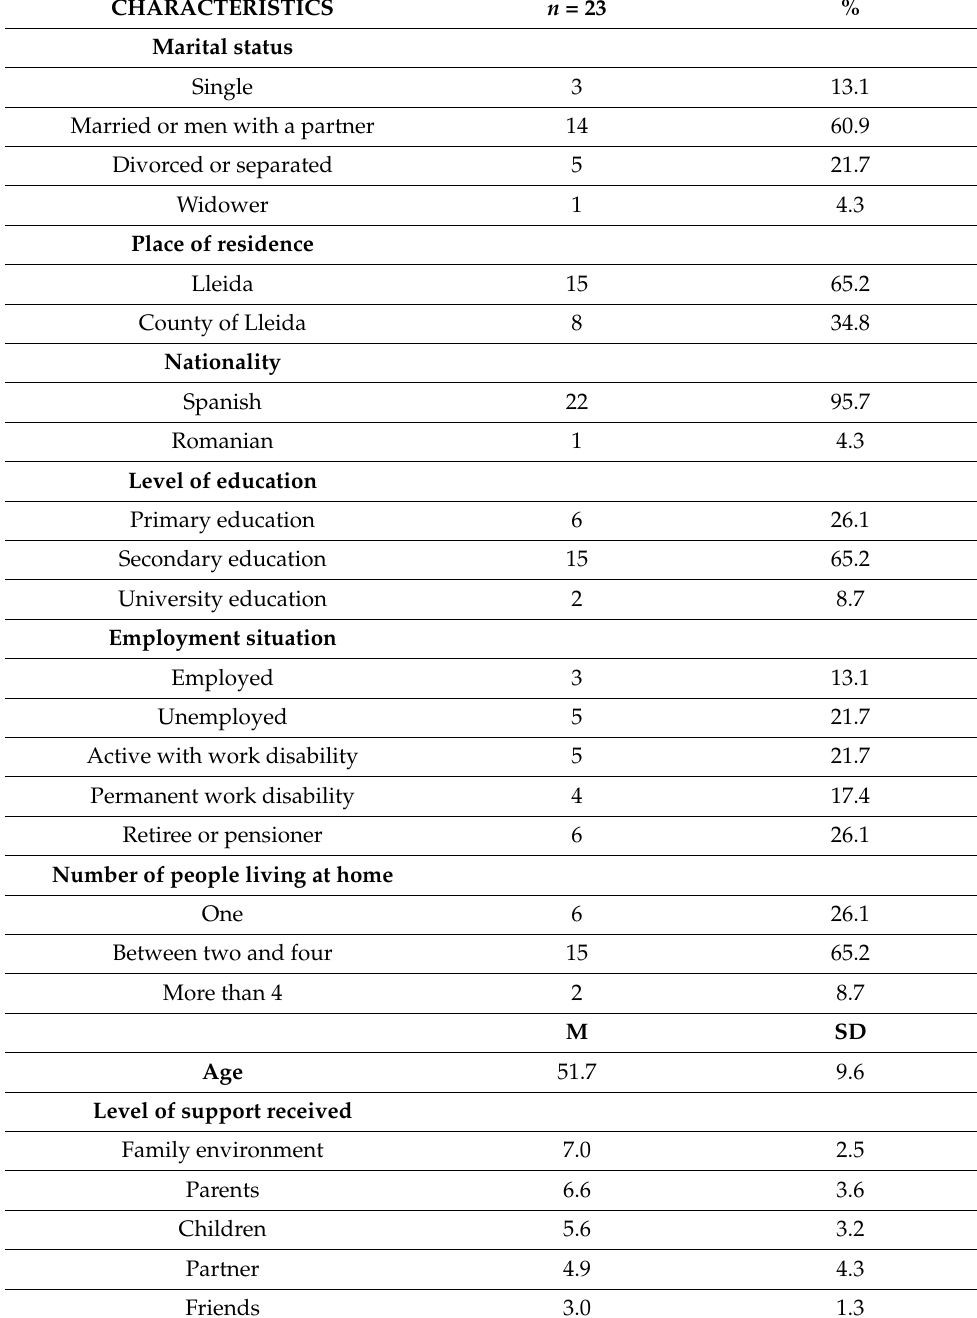
Table 2. Characteristics of the